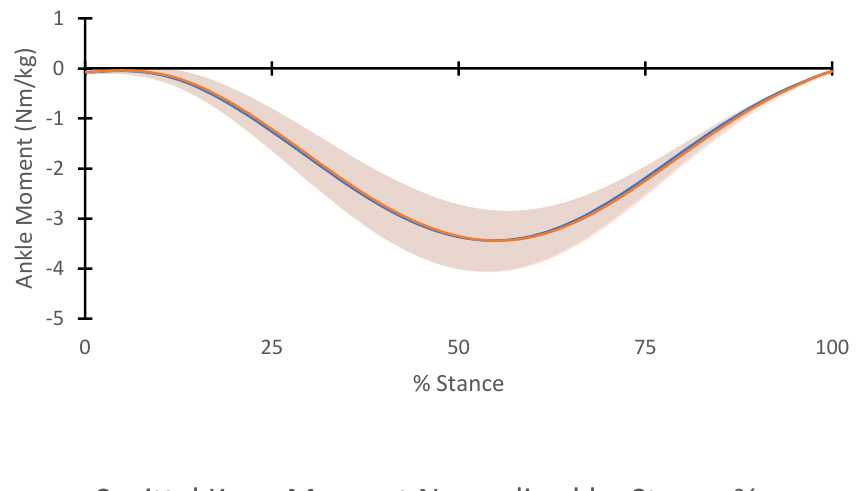
tween shoe conditions as seen in Figure 3.